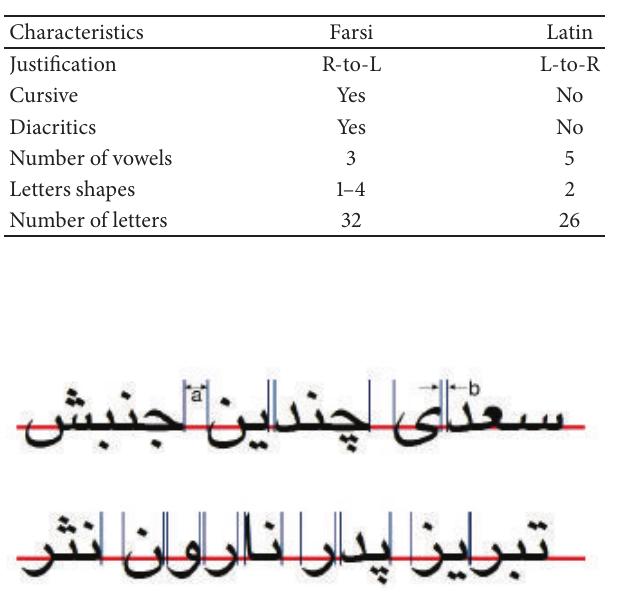
Table 2: Ambiguous patterns in printed words.